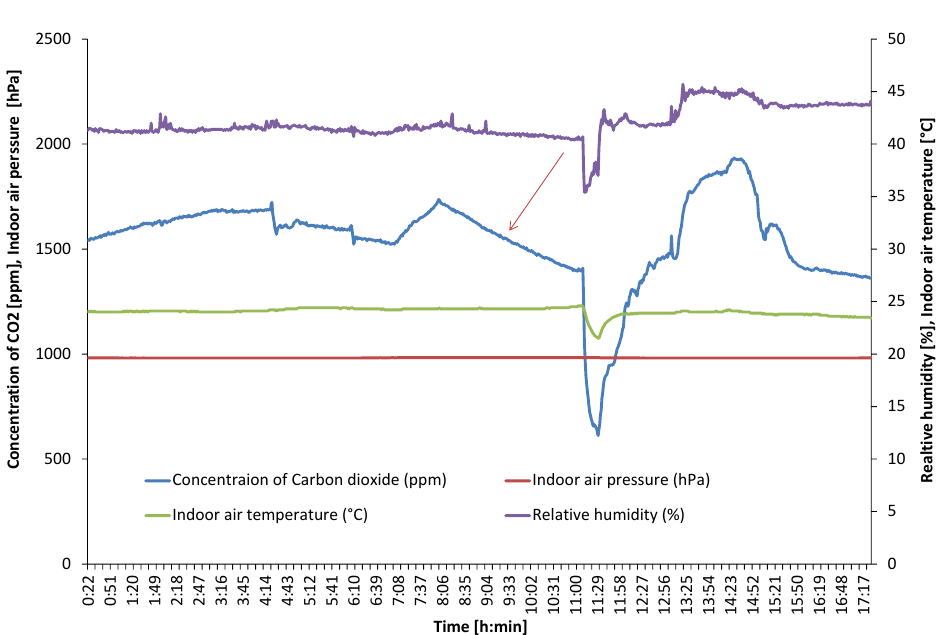
Figure 6. Recording of indoor air quality courses from experimental measurements No 15 (03.02.2019).